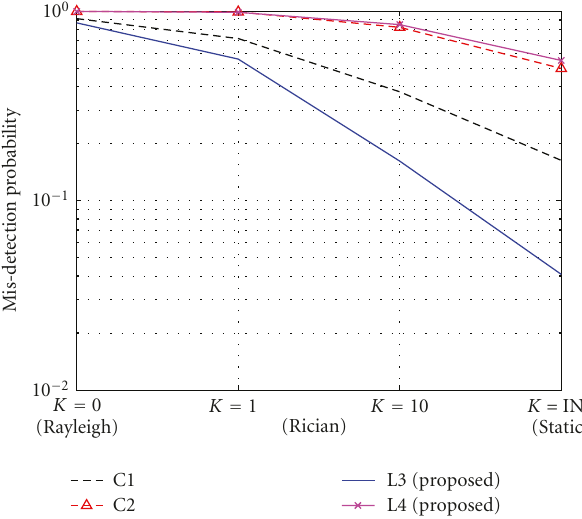
Figure 7: Detection performance as a function of frequency o ff sets (FAR = 10 − 3 , SNR = 0dB).